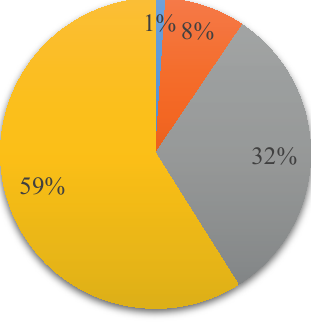
Fig. 3. The number of completed projects.